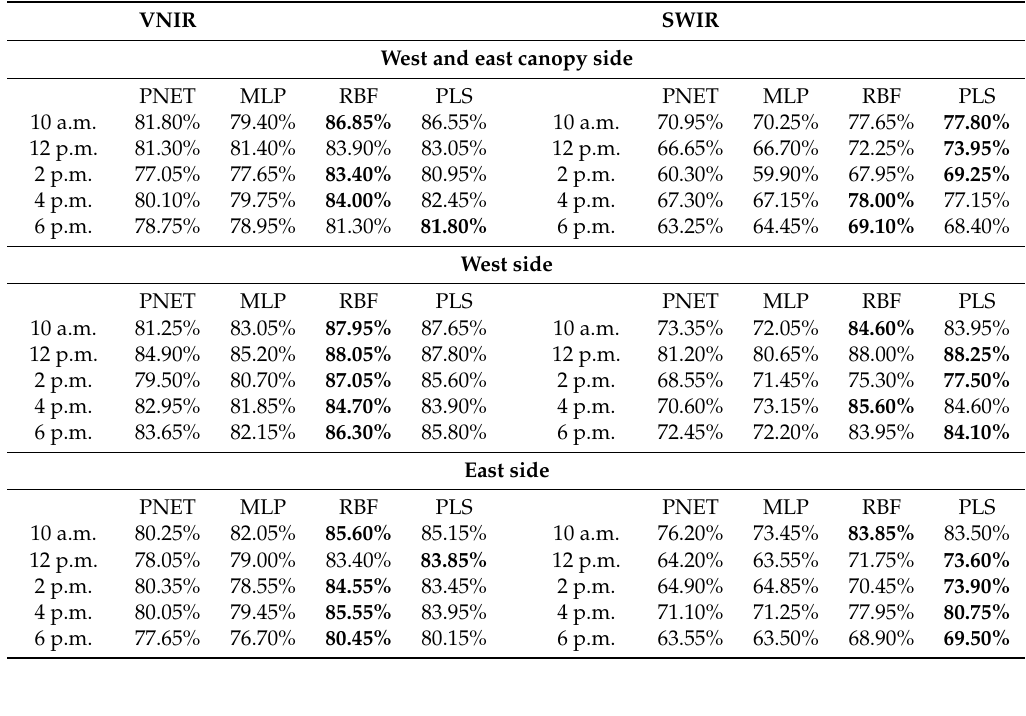
Table 1. Accuracy of spray status prediction based on a single spectrum. Machine learning models tested: Soft-max output layer (PNET), Multi-Layer Perceptron with linear output (MLP), Radial Basis Function (RBF) and network Partially Least Square (PLS) model. The best results, also shown in Figure 9, are marked in bold. Depicted are average performances on the test sets in the 5-fold cross validation.